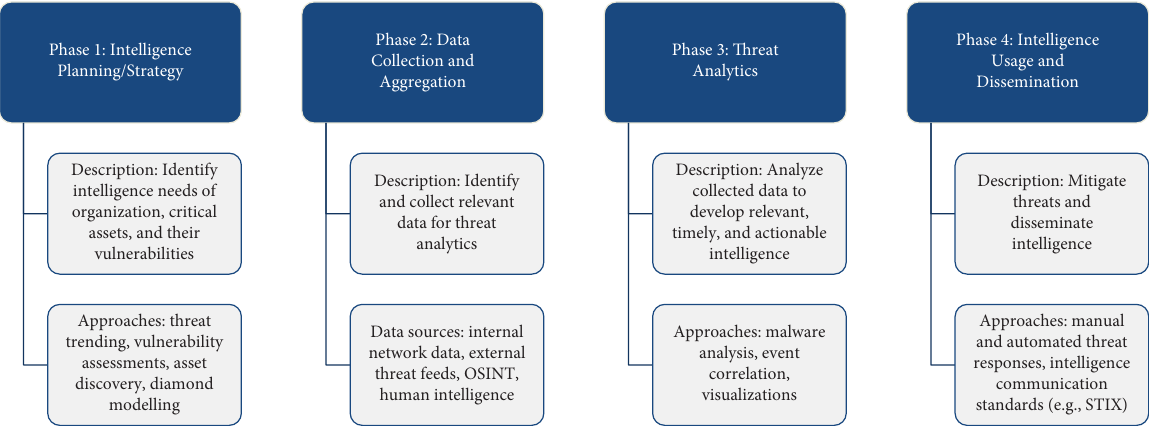
Figure 2: General Cyber Threat Intelligence (CTI) Lifecycle as demonstrated by Samtani et al.